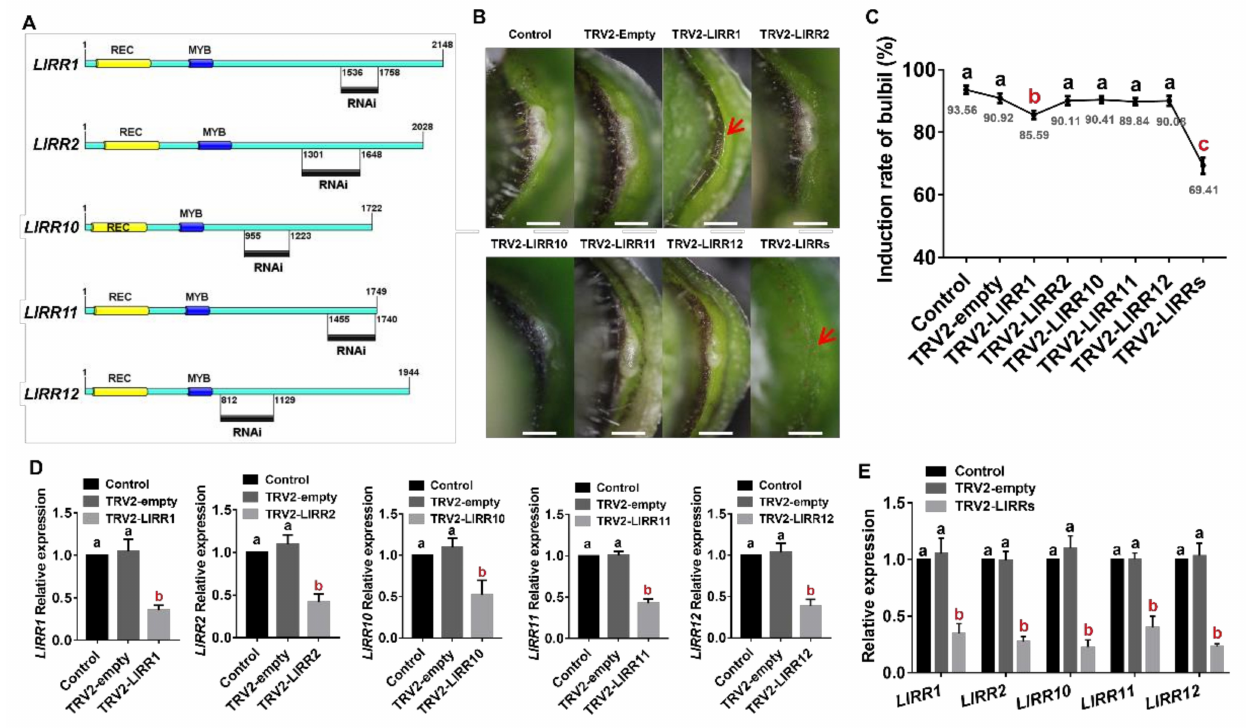
Figure 5. Phenotype and expression analyses after VIGS treatment. ( A ) The gene-specific fragments used in the VIGS experiment. ( B ) The phenotype of leaf axils after VIGS treatment. ( C ) The rate of bulbil formation after two weeks of culture. ( D ) Gene expression after the silencing single type-B LlRR s. ( E ) Gene expression after the silencing of the five type-B LlRR s. Values are means ± SDs ( n = 3). Scale bar in B, 1 mm. The red arrow in B indicates that no bulbil formation is observed on the leaf axil. Lowercase letters (a–c in C ; a–b in D , E ) indicate statistically significant differences at p <